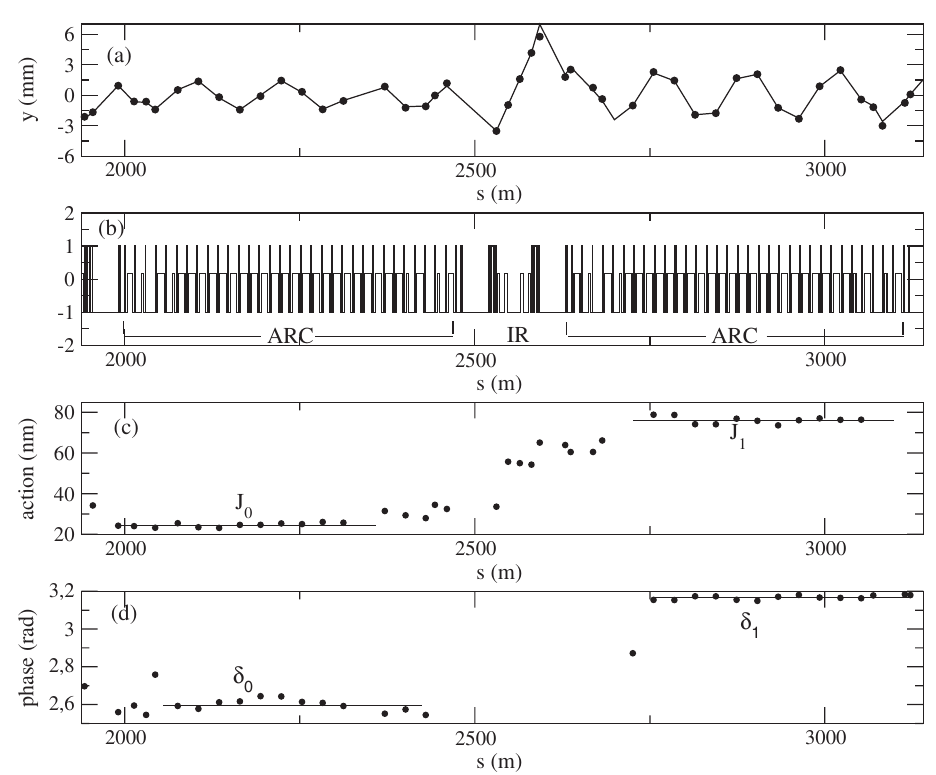
FIG. 8. (a) One of the first difference orbits obtained from beam in RHIC in the year 2000. Each dot represents a BPM measurement. (b) Lattice representation of RHIC. (c) Action plot obtained by applying Eq. (13) to all pairs of adjacent BPM measurements in the ring. (d) Phase plot obtained by applying Eq. (14) to all pairs of adjacent BPM measurements in the ring.